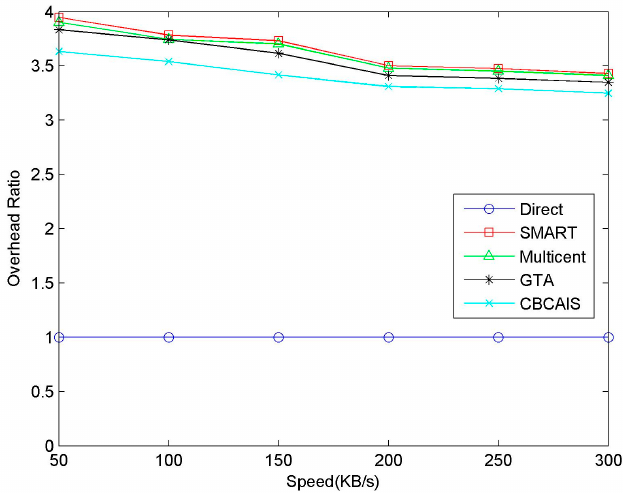
Figure 23. Overhead ratio for varying transmission speeds.